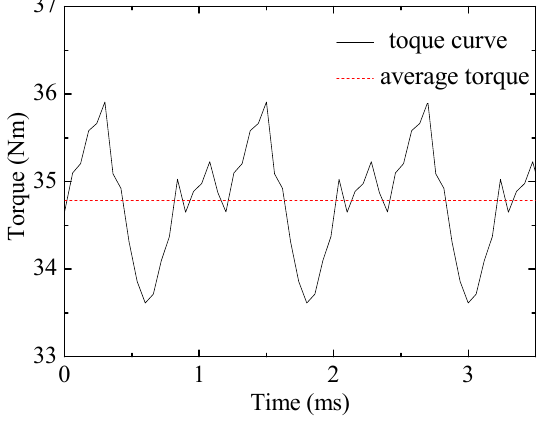
Figure 12. FEM calculated torque curve of the